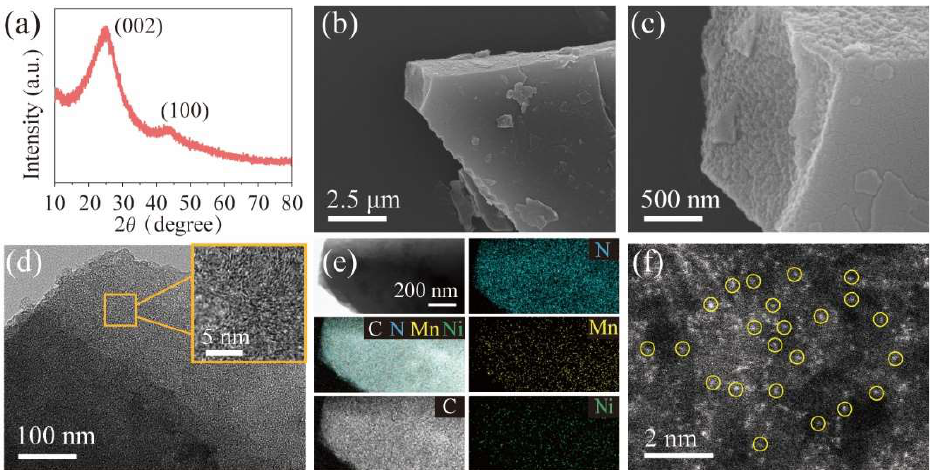
Figure 2. ( a ) XRD pattern, ( b , c ) SEM images, ( d ) TEM images, ( e ) EDS mapping for C, N, Mn, and Ni elements, ( f ) AC HAADF-STEM image of MNNC-2.